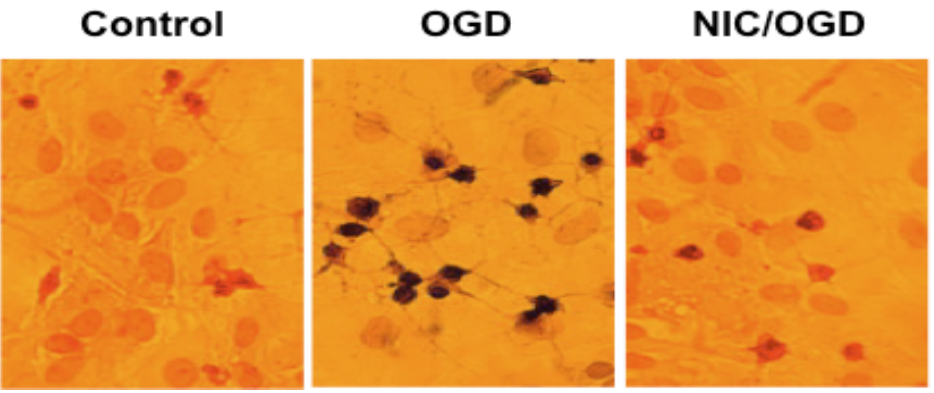
oxygen-glucose (OGD) deprivation . Representative images illustrate that nicotinamide (12.5 mM) with one hour pretreatment prior to OGD significantly blocked neuronal genomic DNA degradation assessed by terminal deoxynucleotidyl transferase nick end labeling (TUNEL) assay 24 hours after